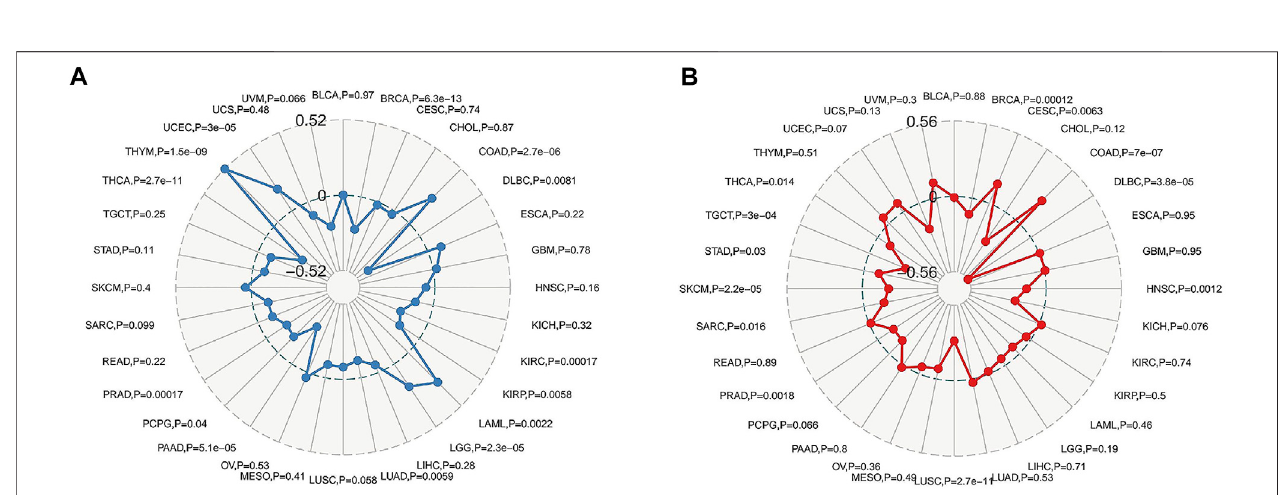
FIGURE 13 | Relationship between FAM46C gene expression and (A) TMB and (B) MSI in pan-cancer.